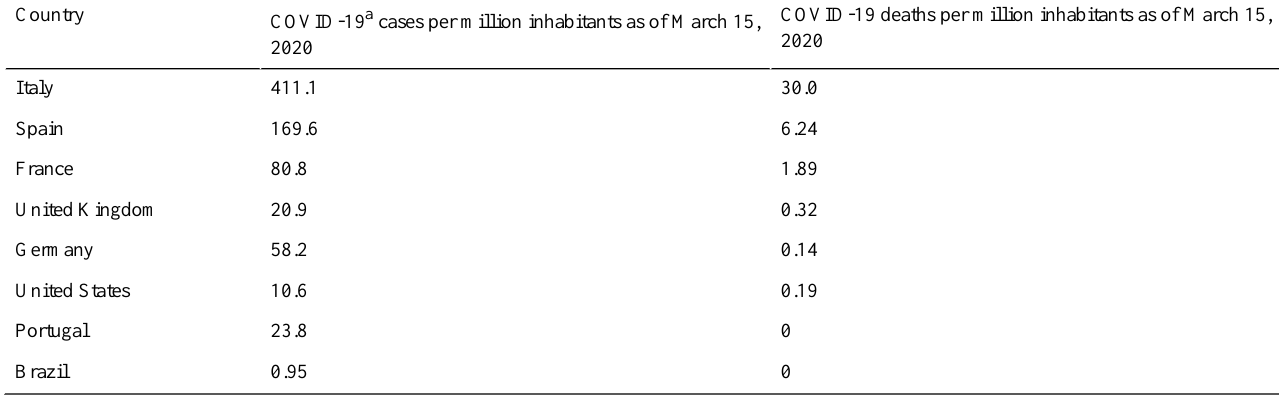
Table 2. Frequency of new COVID-19 cases and deaths in the countries examined in the study. The analysis time frame for new COVID-19 cases was from the date of the first confirmed COVID-19 case in the respective country until March 15, 2020. The analysis time frame for COVID-19 deaths was from the date of the first confirmed COVID-19 death in the respective country until March 15, 2020.